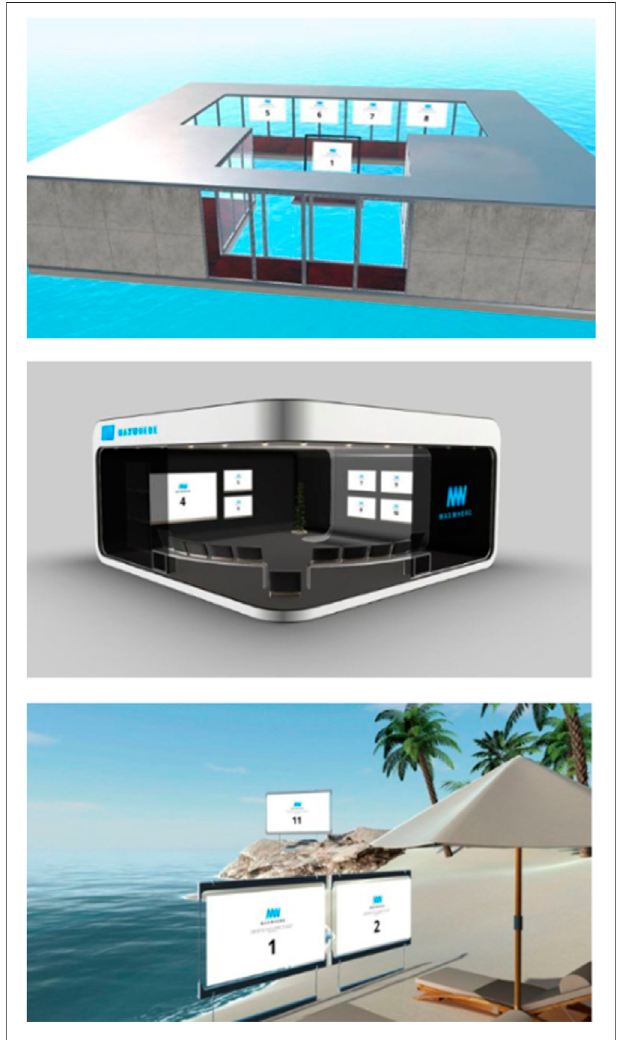
FIGURE 7 | Three spaces at the center of the experiment (from top to bottom: “ Glassy Small ” , “ Let ’ s Meet ” and “ Seminar on the Beach ” ).